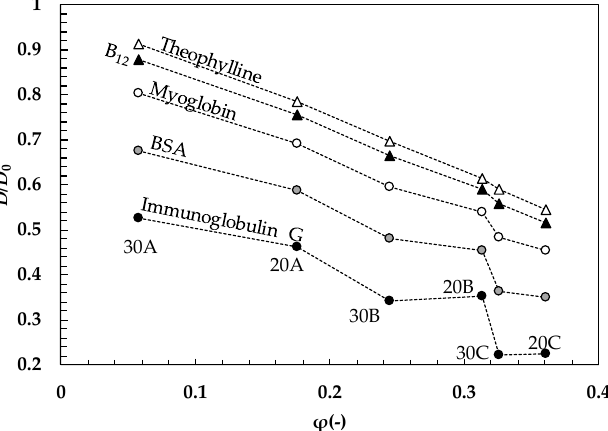
Figure 5. Variation of the drug diffusion coefficient ( D ) according to Equation (10) assuming Y = 1, drugs of different size ( r s ), and the couples of ξ – φ competing with the six studied hydrogels (Figure 3 and Table 4). D 0 is the drug diffusion coefficient in pure water at 37 °C.